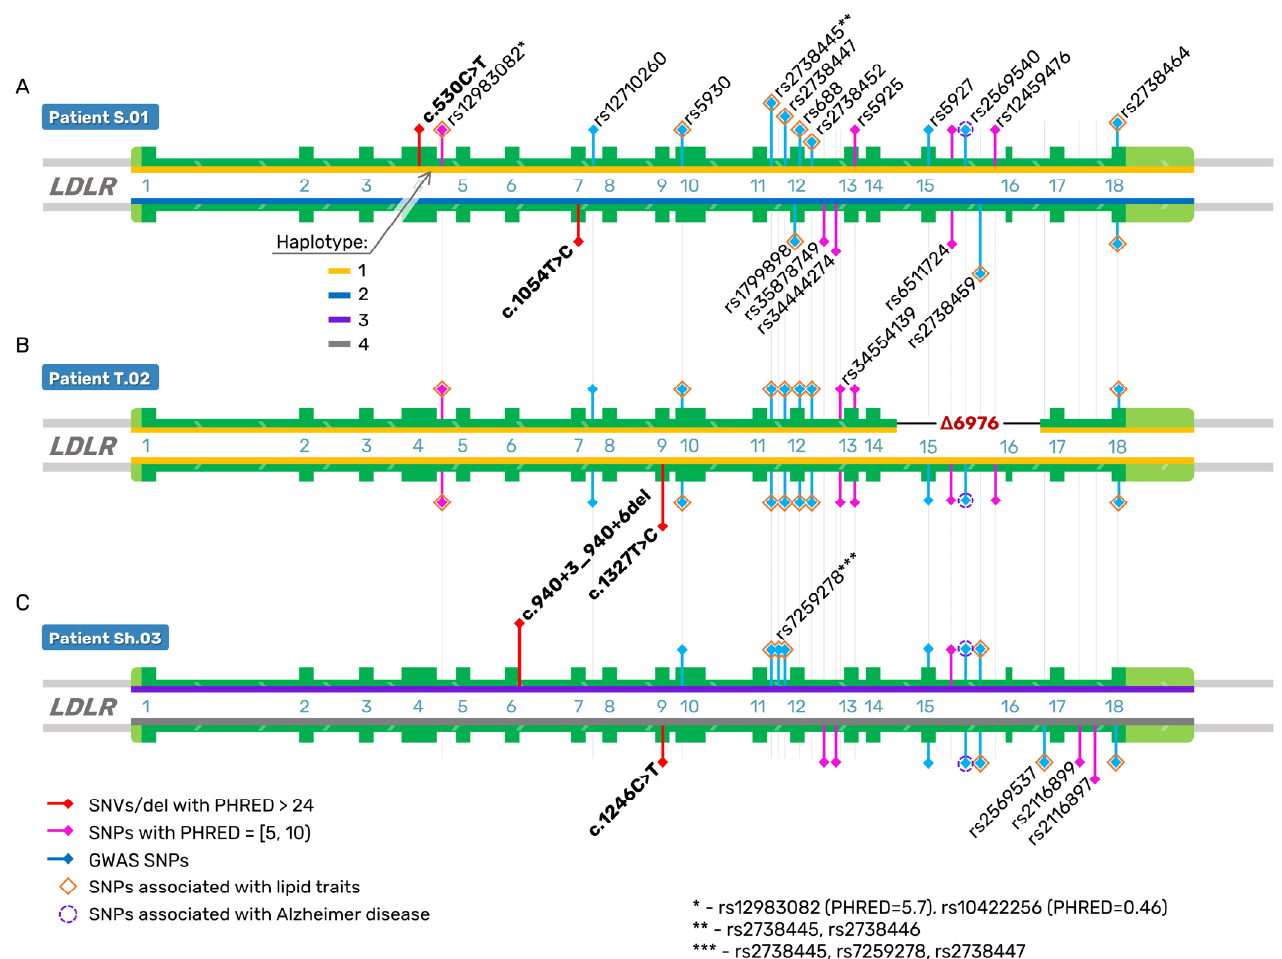
Figure 4. Detection and phasing of five rare pathogenic variants and common SNPs of LDLR gene with the highest CADD score statistic (PHRED) in the patients with compound heterozygous FH. ( A ) Haplotype structure of LDLR gene of S.01 patient. ( B ) Haplotype structure of LDLR gene of T.02 patient. ( C ) Haplotype structure of LDLR gene of Sh.03 patient.